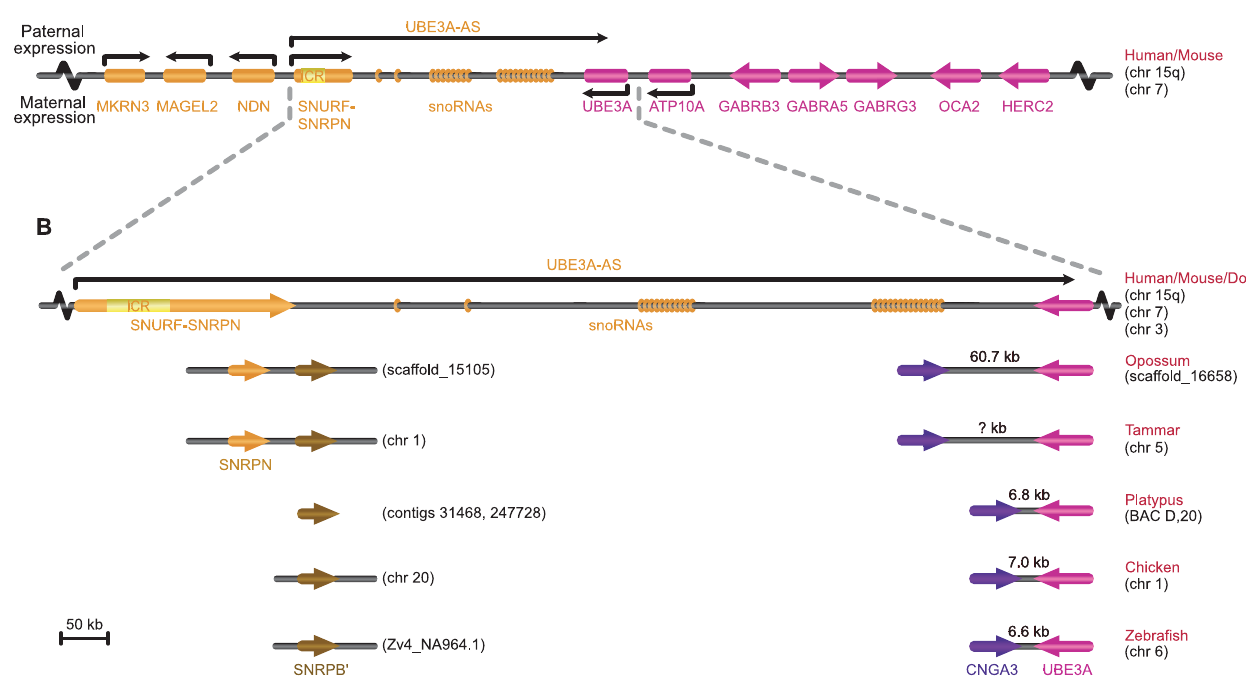
Figure 1. Genes of the PWS-AS Imprinted Domain (A) The PWS-AS imprinted domain in human and mouse. Paternal or maternal expression is indicated by arrows. The yellow region of SNURF/SNRPN represents the ICR. UBE3A - AS is an antisense transcript that includes arrays of untranslated snoRNA genes. (B) Comparison of the eutherian SNRPN – UBE3A region with its ancestral arrangement in non-eutherian vertebrates. Pink represents genes that are co- linear in humans through to fish, purple represents human Chromosome 2 genes that are adjacent to the PWS-AS homologous region in the ancestral arrangement, orange represents eutherian-specific genes or elements, and brown the unlinked gene SNRPB 9 that duplicated to form SNRPN . In marsupials, monotremes, chicken, and fish, UBE3A lies close to a human Chromosome 2 gene CNGA3, and there are no snoRNAs. In zebrafish, chicken, and platypus, only SNRPB 9 is present, but in marsupials tandem duplication gave rise to SNRPN, which was relocated next to UBE3A in eutherians. DOI: 10.1371/journal.pgen.0020182.g001